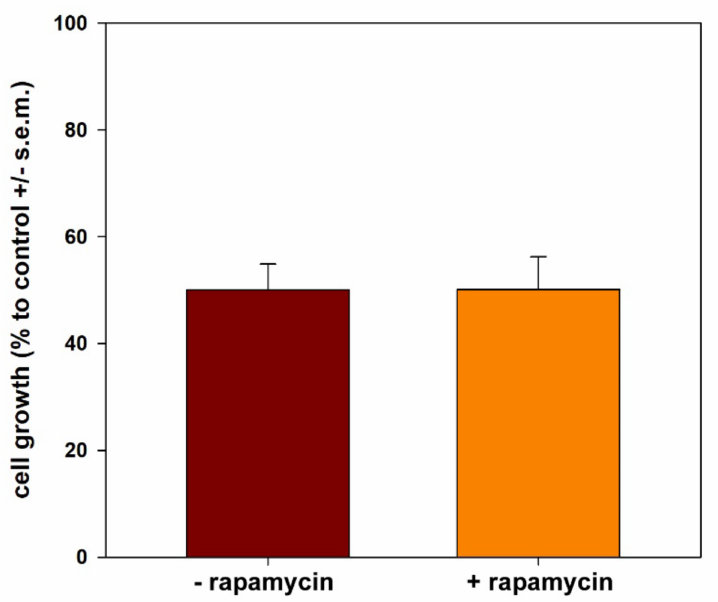
Figure 9. Bar graphs showing the absence of a statistically significant effect by 1 nM rapamycin co- treatment on CFE-induced decrease in cell number after 24 h of exposure. The error bars correspond to the standard error of the mean (s.e.m.) of three independent measurements.